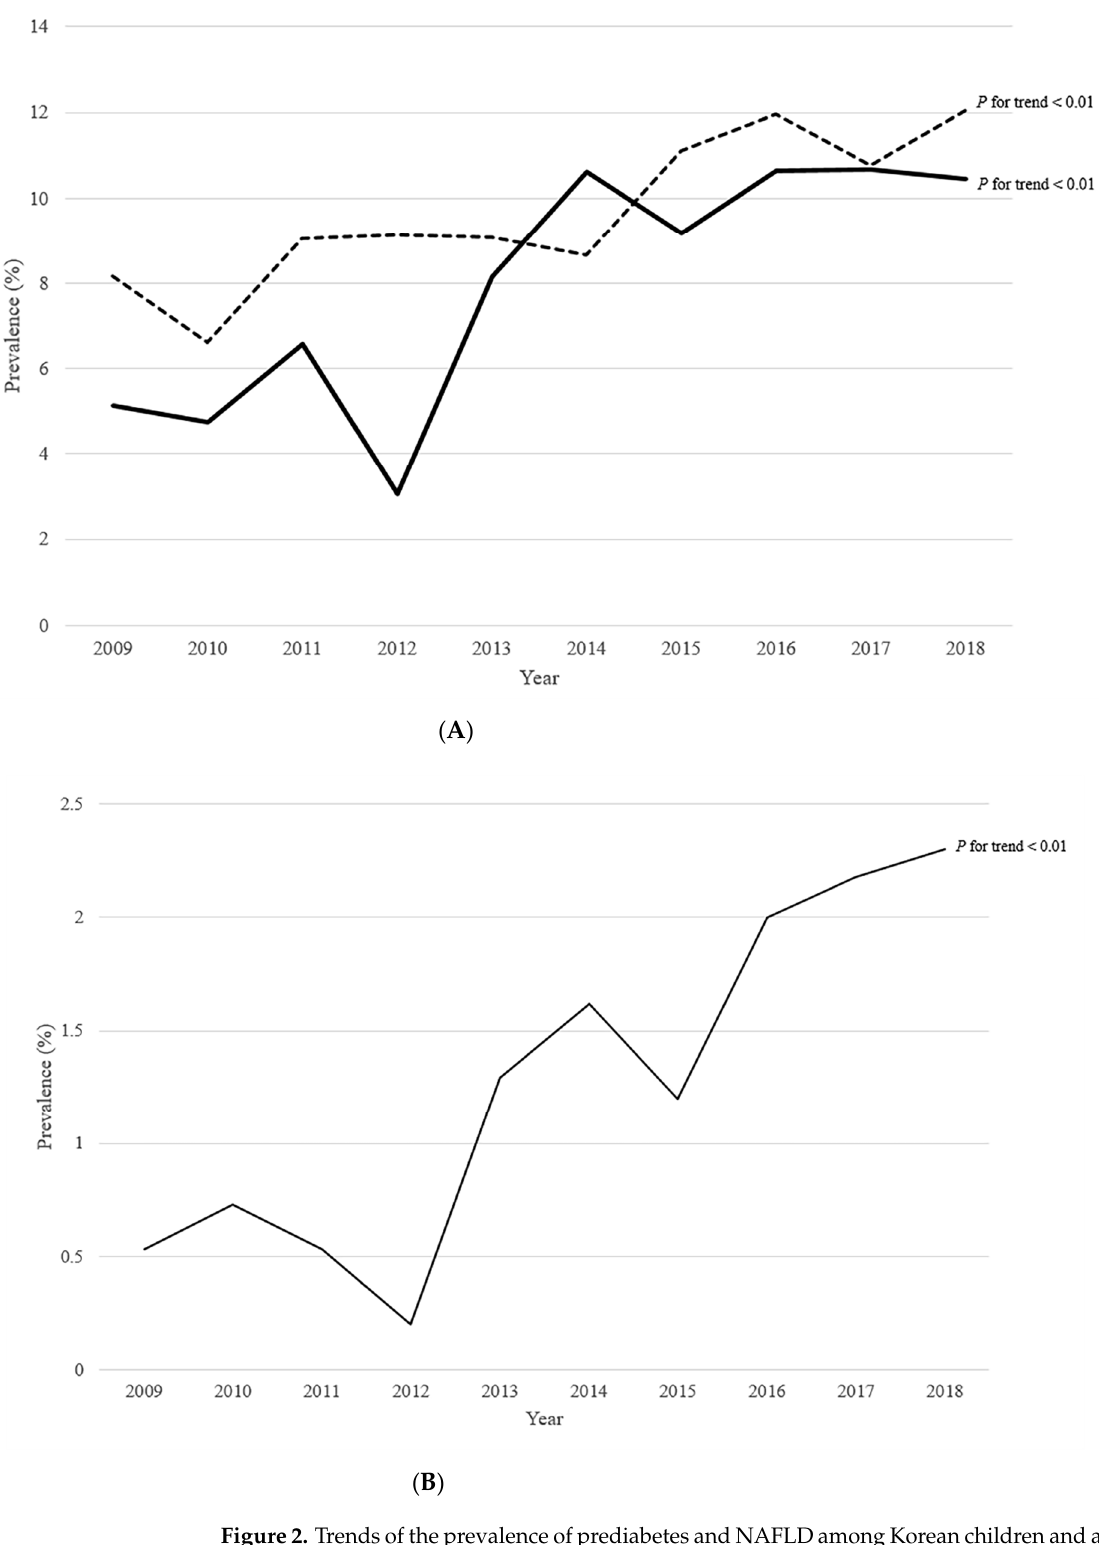
Figure 2. Trends of the prevalence of prediabetes and NAFLD among Korean children and adolescents between 2009 and 2018. Linear trend analysis was performed using coefficients of orthogonal polynomials to calculate p for trend. ( A ) The black solid line is the prevalence of prediabetes and the dashed line is the prevalence of NAFLD ( B ) The black narrow line is the prevalence of subjects with prediabetes and NAFLD. NAFLD: non-alcoholic fatty liver disease.